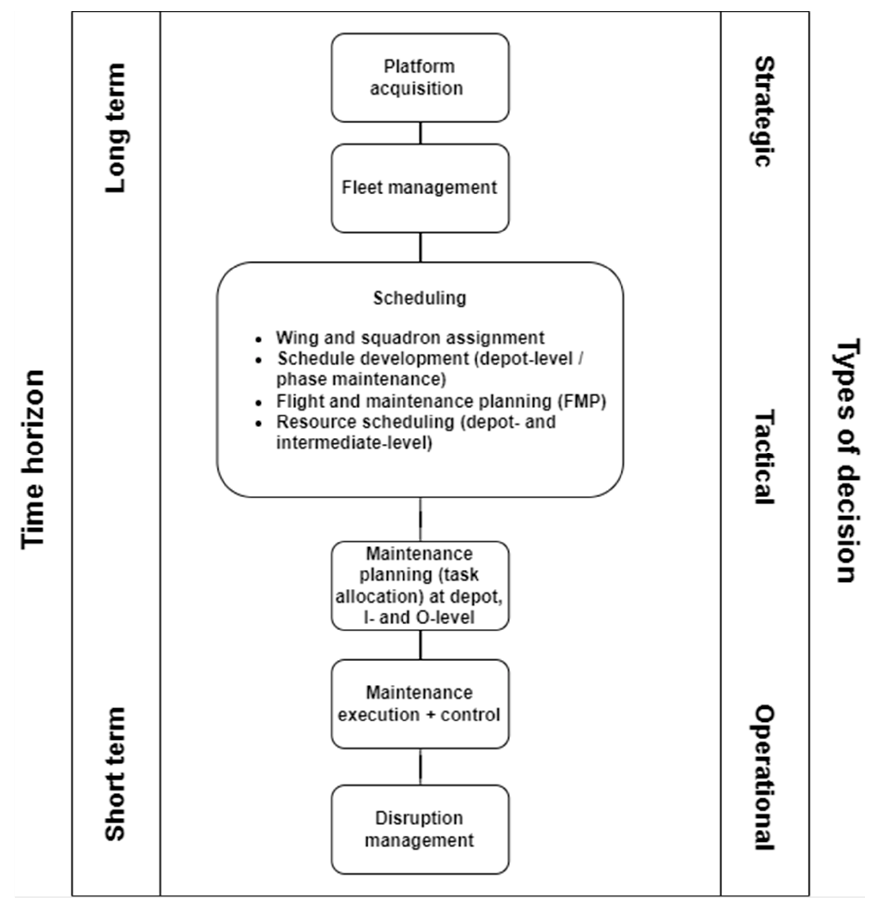
Figure 6. Defence maintenance activities across time horizons and types of decision (adapted from [149]) .